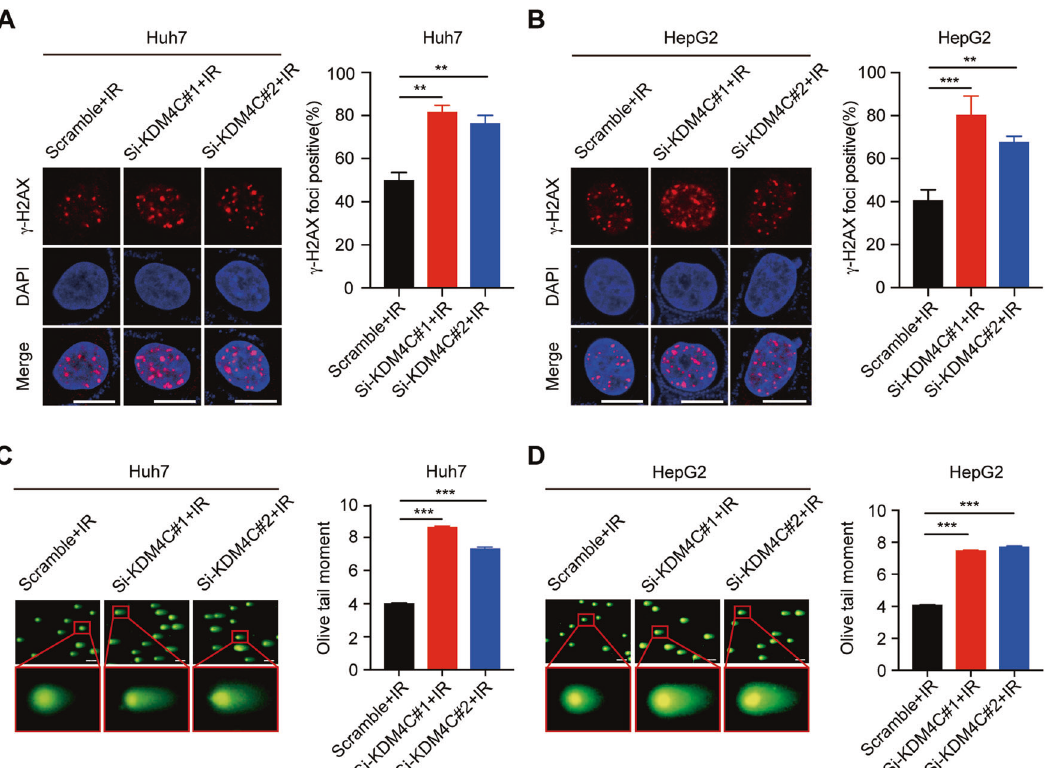
Fig. 4 Knockdown of KDM4C enhances IR-induced DNA damage in HCC cells. A , B Immuno fl uorescence staining of γ -H2AX foci was conducted to measure the effect of KDM4C depletion on IR-induced DNA damage in Huh7 and HepG2 cells. Representative images and γ - H2AX-positive cell quanti fi cation are shown ( n = 3). Scale bar, 10 μ m. C , D A neutral comet assay was carried out in Huh7 and HepG2 cells to assess single-cell DNA damage post-irradiation in each group. Images were captured under an immuno fl uorescence microscope, and the Olive Tail Moment was calculated using CometScore2.0 is presented ( n = 3). Scale bar, 50 μ